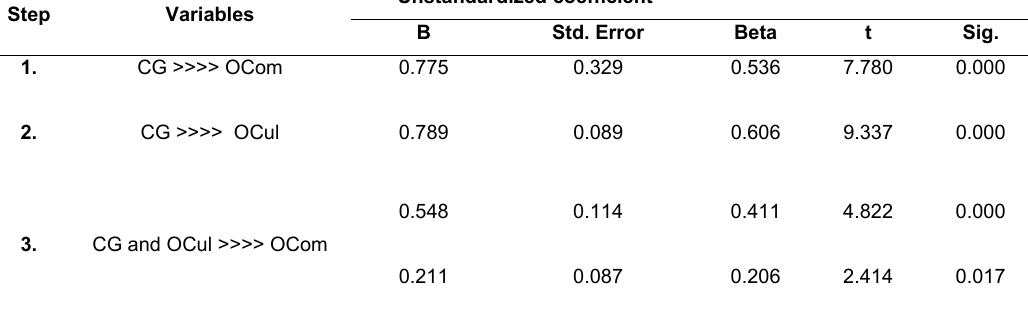
Table 11. The three-step model (H 4 ).